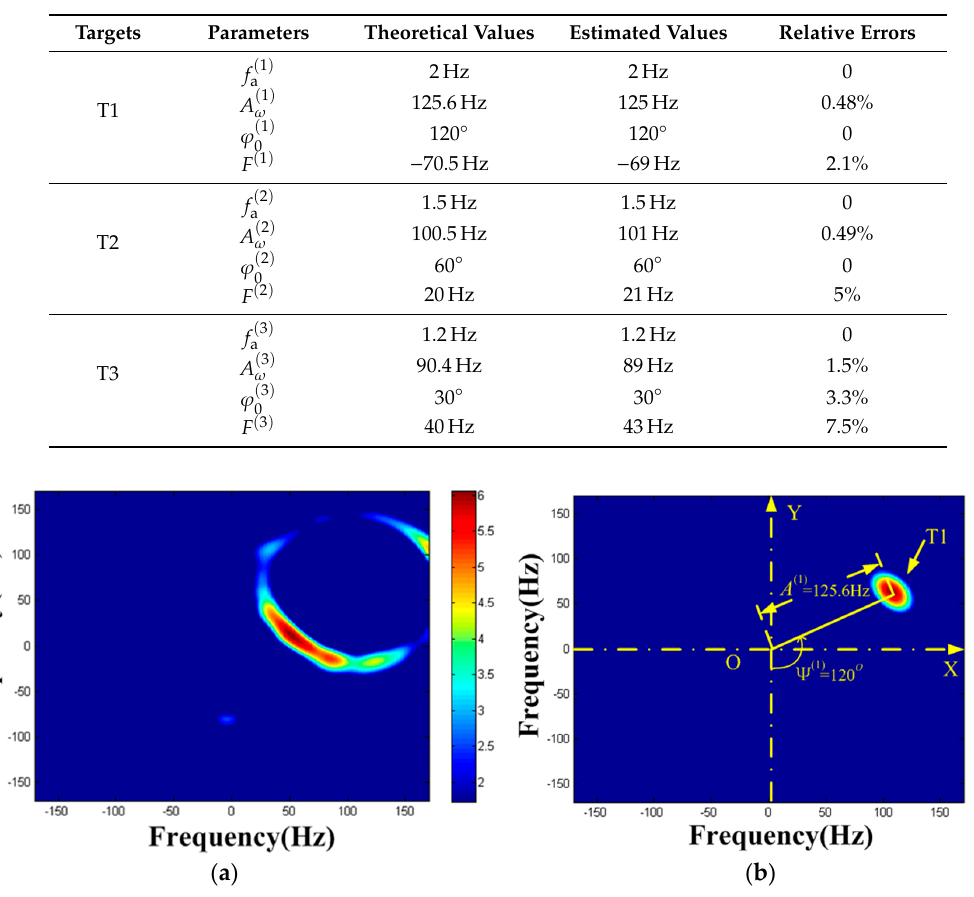
( ) 53m,8000m,0 − Figure 9. IRT result. ( a ) When the rotational center coordinate of T1 is ( − 53m,8000m,0 ) . ( b ) When Figure 9. IRT result. ( a ) When the rotational center coordinate of T1 is . ( b ) When the ( ) 0,8000 m,0 the rotational center coordinate of T1 is ( 0,8000m,0 ) . rotational center coordinate of T1 is .